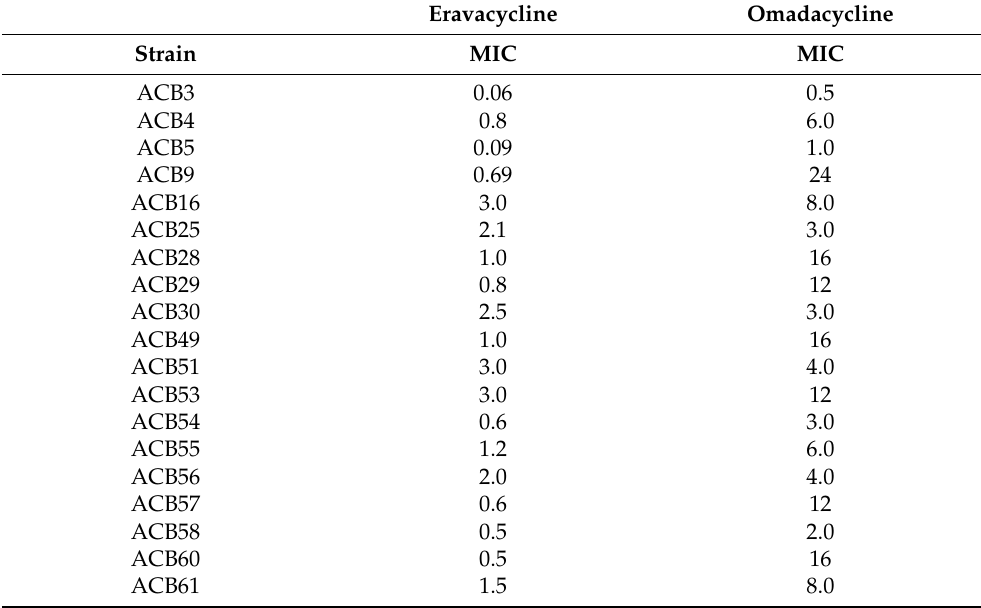
Table 2. Average eravacycline and omadacycline MICs ( µ